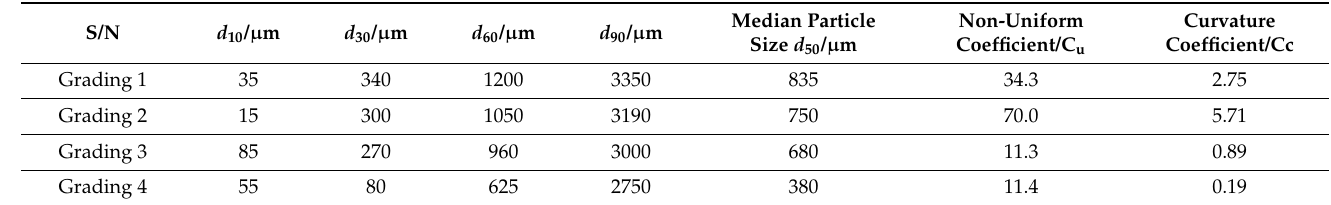
Table 2. Characteristic indices of particle size